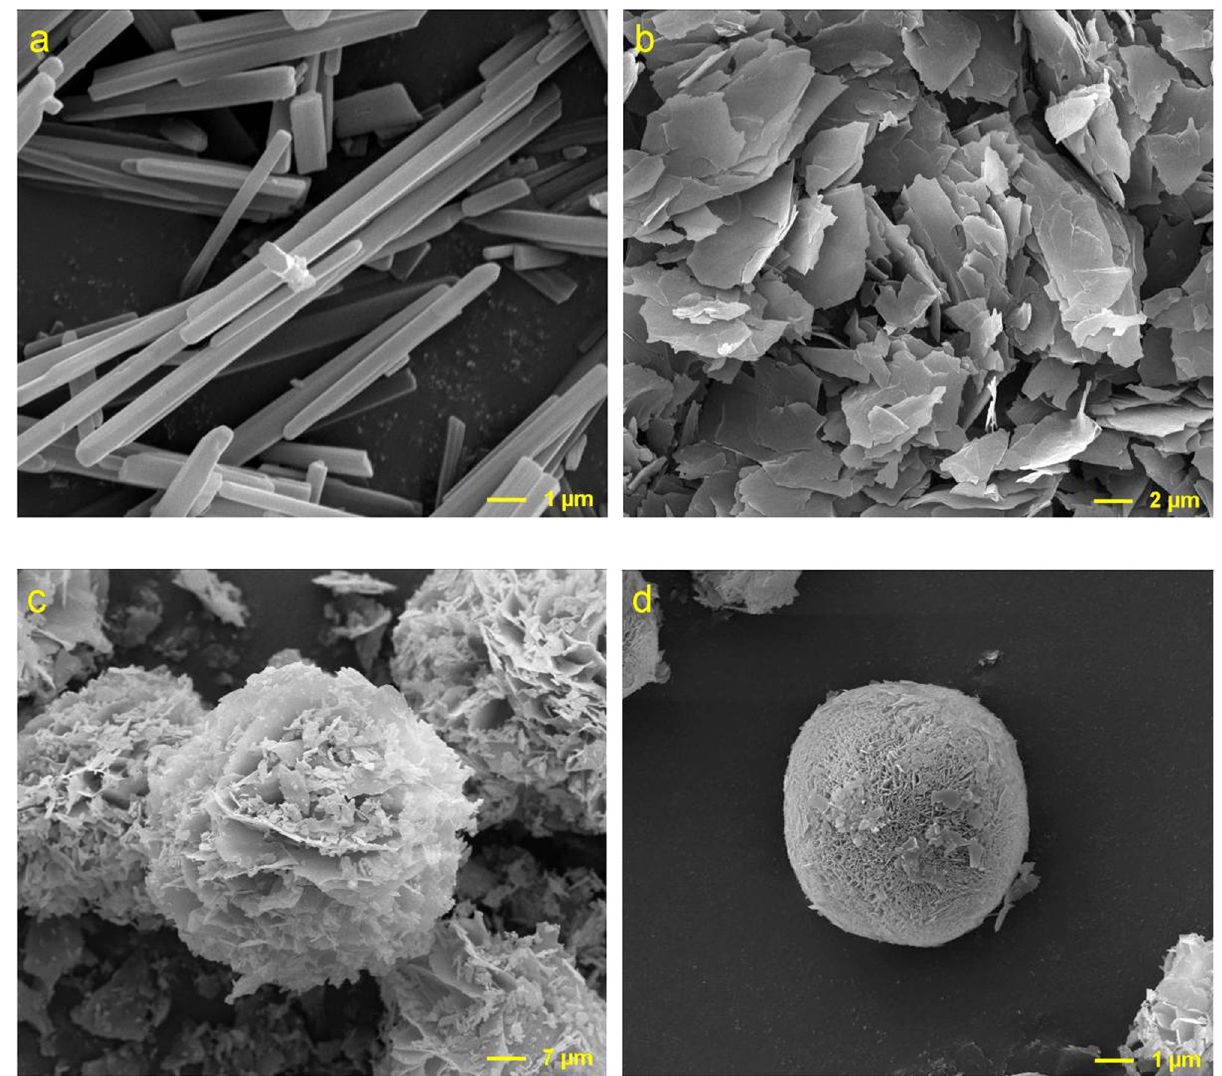
Figure 1: Typical SEM images for the magnesium carbonate hydrate particles during the talc carbonation: ( a ) needle - like, ( b ) sheet - like, ( c ) rose - like, ( d ) nest -